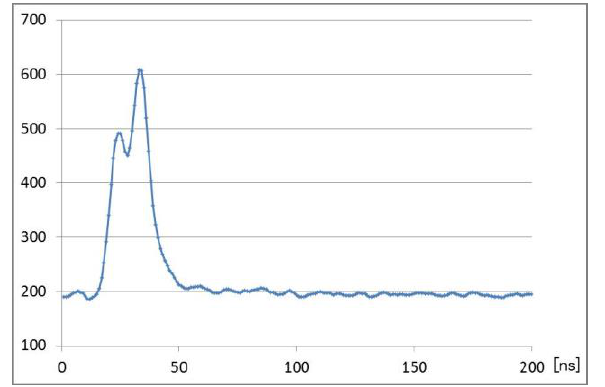
Figure 6. Waveform of Sudajii (three points)